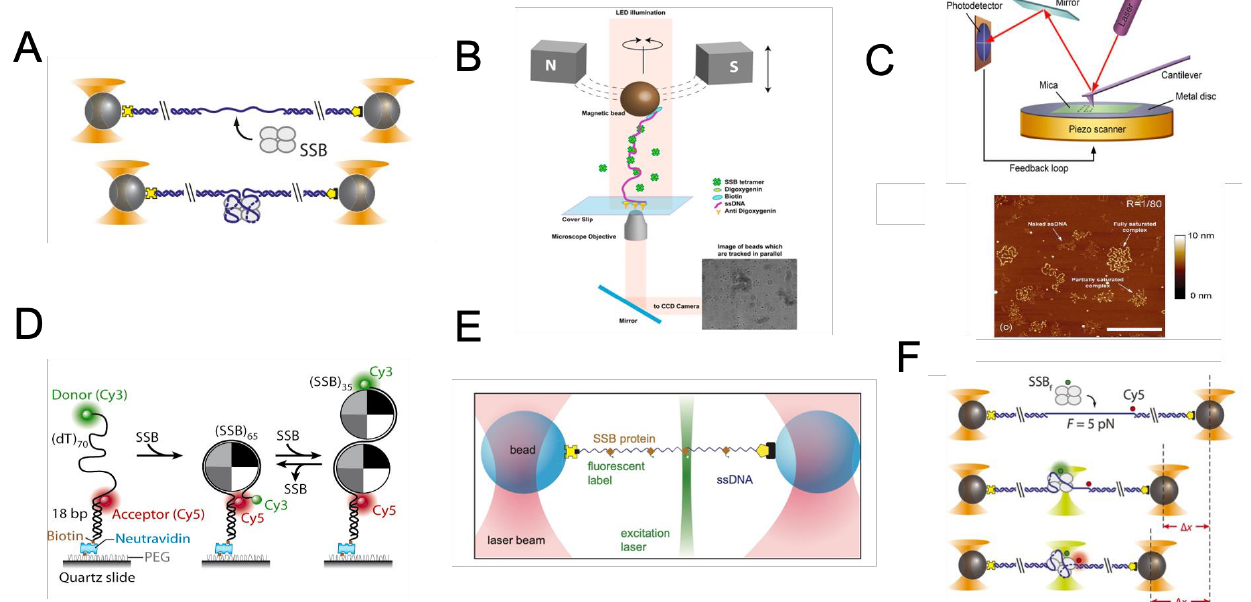
Figure 2. Overview of the Single-Molecule Toolbox for Studying SSB. ( A ) Dual optical tweezers for E. coli SSB unwrapping studies: This illustration shows a DNA construct containing two long double-stranded DNA handles, and a short single-stranded DNA fragment is trapped between two beads using optical tweezers. The binding of a single SSB tetramer is then studied by measuring the shortening of the DNA construct. (Adapted from Figure 1B of [16] with CC BY 4.0 License). ( B ) Magnetic Tweezers Assay: In this experiment, a unique DNA construct is secured between a cover glass and a paramagnetic bead, held in place by a magnetic field. The SSB-containing buffer is introduced and ejected to study the interaction between single-stranded DNA and SSB, providing insight into the mechanics of DNA-protein interactions. ( C ) Atomic Force Microscopy for Studying SSB-DNA Interactions: This illustration shows an AFM setup for imaging SSB and DNA interactions. The sample is probed using a flexible cantilever to obtain a three-dimensional image. An example image shows the different forms of M13 ssDNA- E. coli SSB complexes captured by AFM.